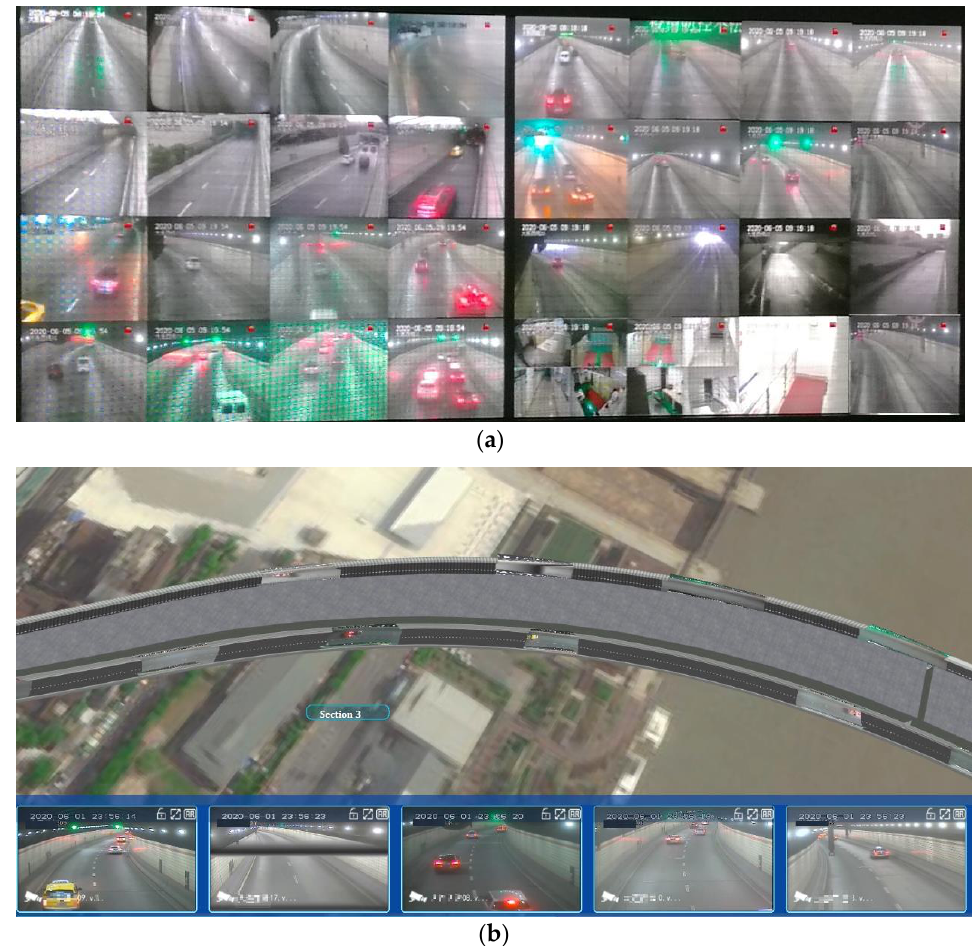
Figure 16. Comparison of tunnel global monitoring effect before and after demonstration: ( a ) Fragmented 2D matrix monitoring; ( b ) global top view monitoring with spatial relevance.